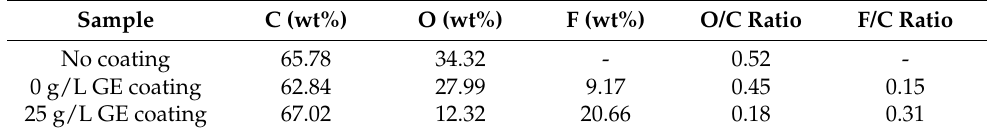
Figure 10. Surface energy dispersive spectrometry (EDS) analysis of nonwoven and composites. Table 4. Element distribution on the surface of nonwoven and composites.